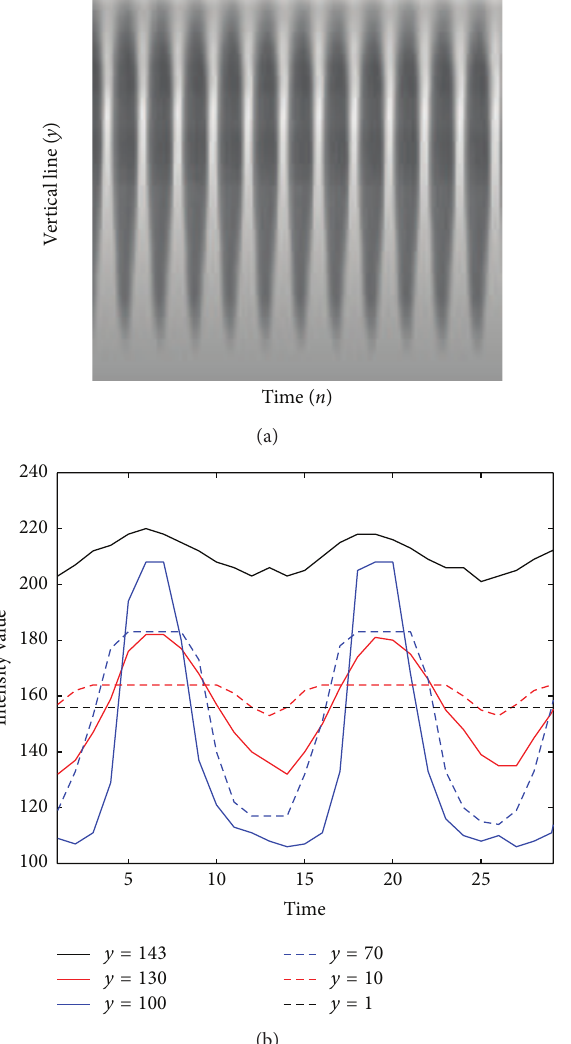
Figure 12: (a) Vertical slice image (VSI), intensity variation along the vertical slice of masked image. (b) Intensity variations of VSI image for different vertical lines.